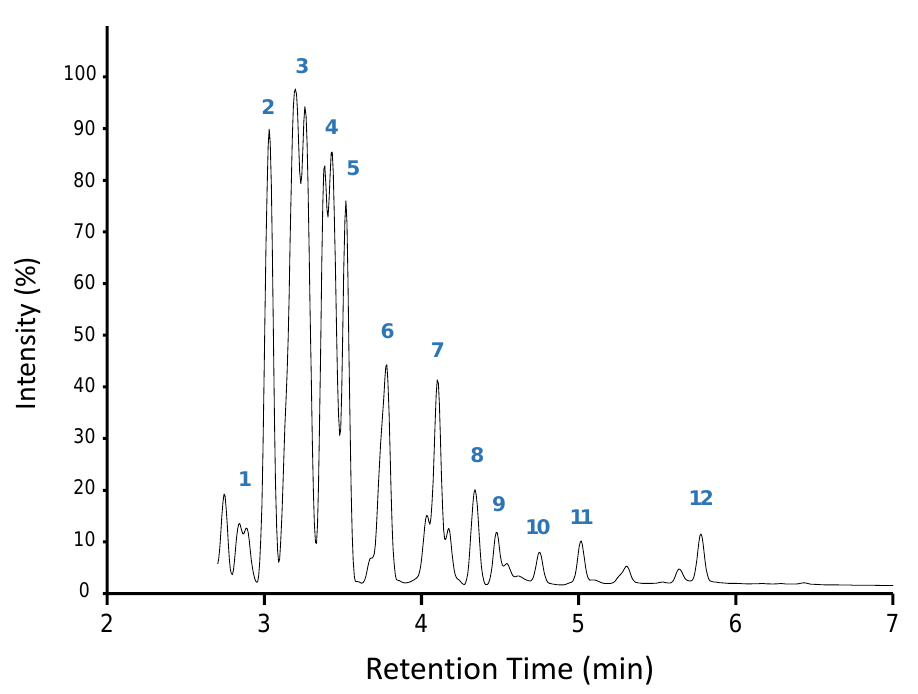
Figure 4. TIC of 31 amino acids derivatized with MTBSTFA using the “short optimized” GC -MS method program. 1. Alanine, glycine; 2. 2-Aminoisobutyric acid, Sarcosine; 3. β -Alanine, 2-Amino- butyric acid, 3-Aminobutyric acid, 3-Aminoisobutyric acid, valine, norvaline; 4. Isovaline, leucine, isoleucine, allo-isoleucine, norleucine, ɣ -Aminobutyric acid, 5. Proline, 6. β -Leucine; 7. Methionine, serine, isoserine, threonine; 8. Phenylalanine, homoserine; 9. Aspartic acid, 10. Glutamic acid, 11. Lysine; 12. Tyrosine. To delve further into the data analysis, mass fragmentograms could also be used (Figures 5, 6, 7 and 8) with a highly specific mass fragmentation even for coeluting com- pounds.